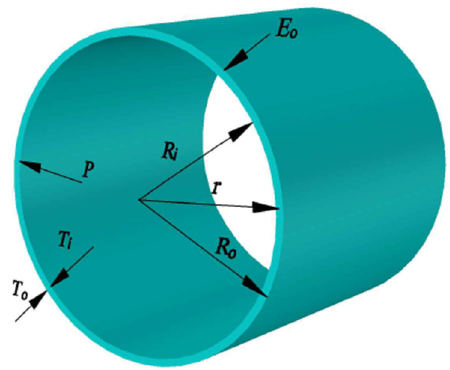
Figure 5. Cylinder model with geometrical parameters and applied loads.